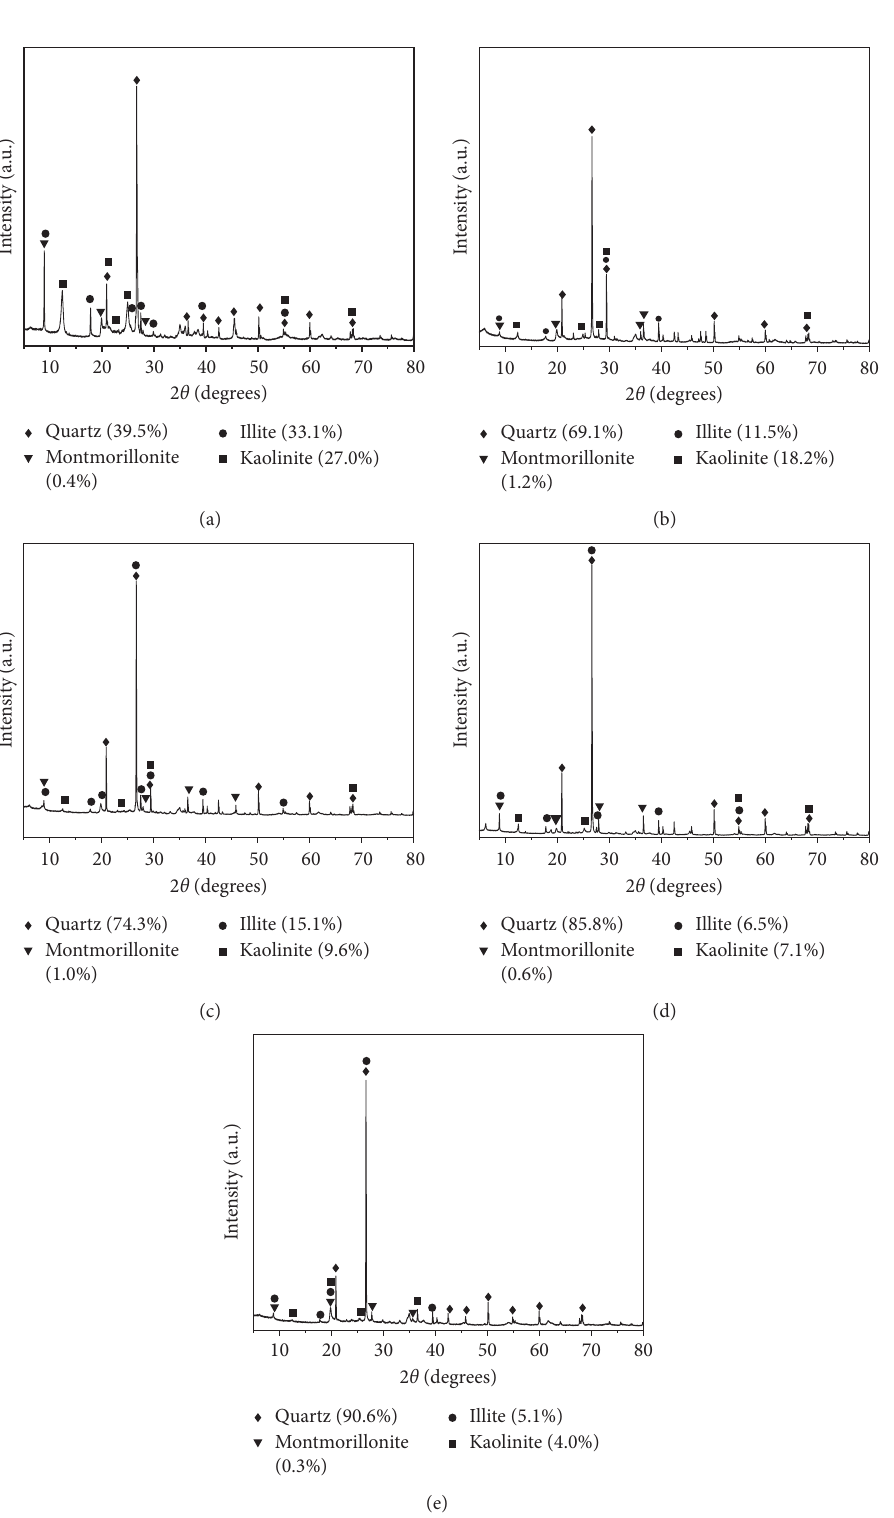
Figure 4: X-ray diffraction patterns for different soil specimens. (a) CH soil. (b) MH soil. (c) CL soil. (d) ML soil. (e) SC